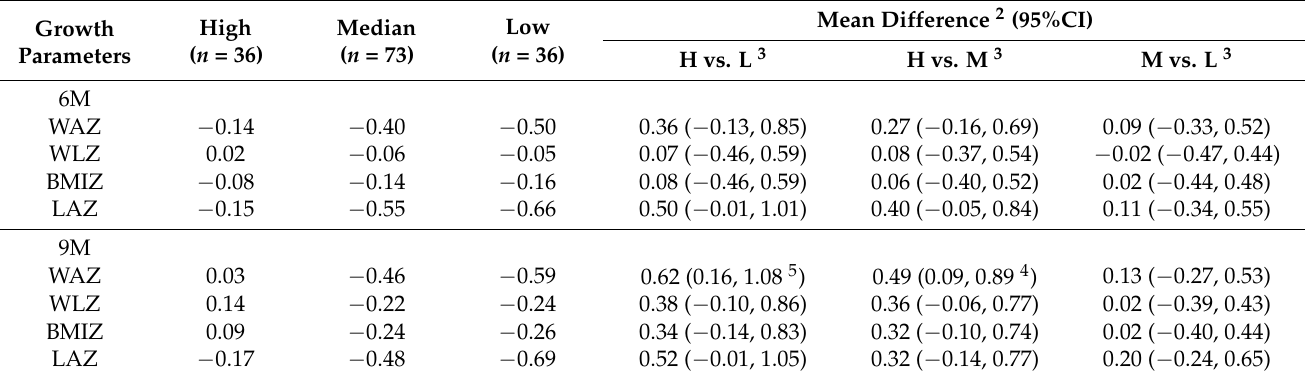
Table 3. Comparison of growth among infants in different protein intake groups 1